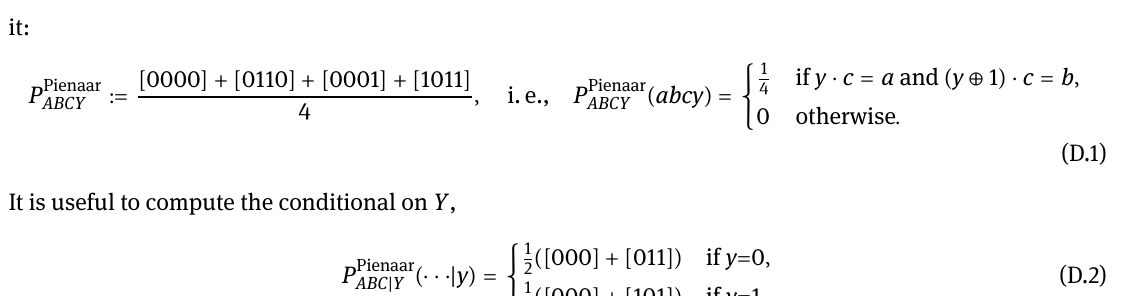
Figure 18: The Russian dolls inflation of